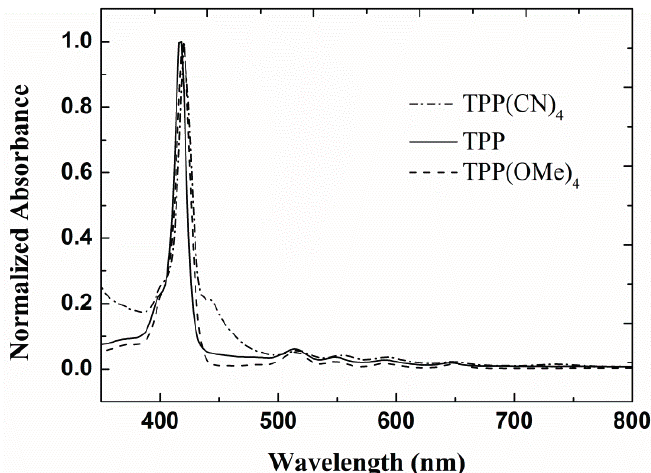
Figure 2. UV-visible absorption spectra of TPP, TPP(CN) 4 , and TPP(OMe) 4 in CH 2 Cl 2